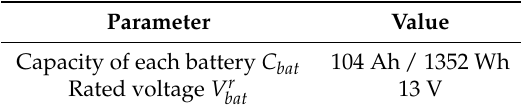
Table 4. Parameters of each unit of the energy storage subsystem (1352